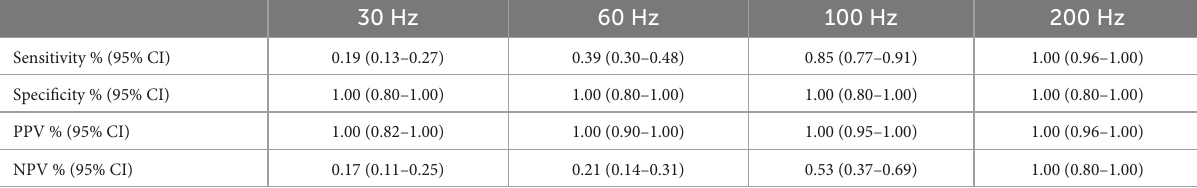
TABLE 3 Results and diagnostic accuracy of different high-pass filter for detecting discrete local ventricular EGM.